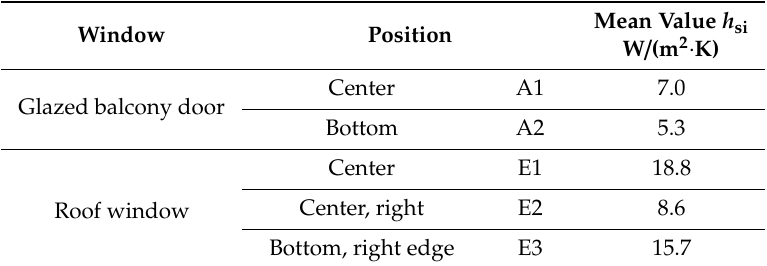
Table A2. Surface heat transfer coe ffi cient—overview of measured